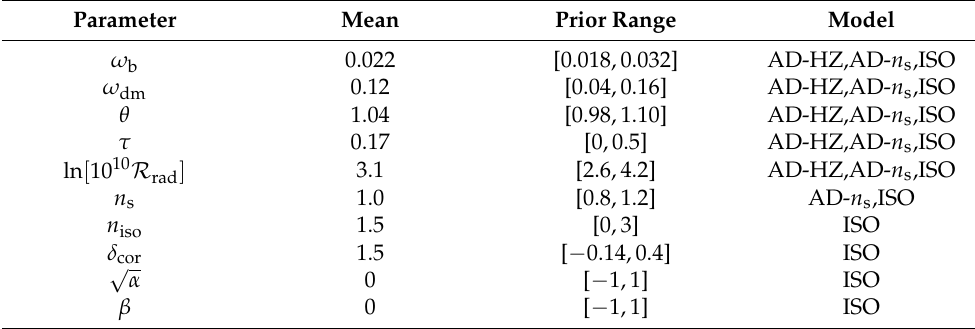
Table 2. The parameters used in the models; see ref. [12] for nomenclature and other details. For the AD-HZ model n s was fixed to 1 and n iso , δ cor , α and β were fixed to 0. In the AD- n s model, n s also varies. Every isocurvature model holds the same priors for the whole set of parameters.